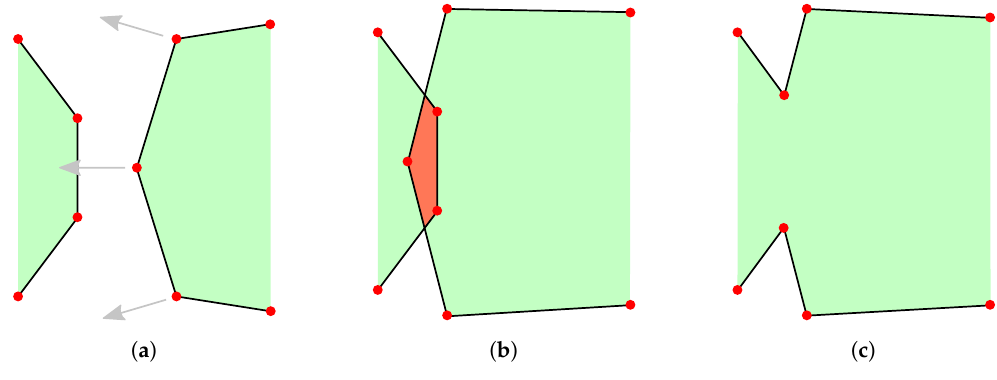
Figure 1. Two explicit surfaces merging by movement of nodes: ( a ) initial geometry with included area (green); ( b ) broken final geometry due to a surface overlap (red); ( c ) correct surface after merging of the two surfaces. In order to reach the correct surface representation, additional meshing steps are necessary, decreasing